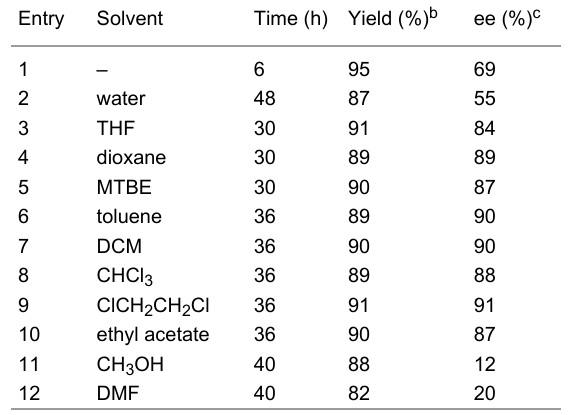
Table 2: Effect of the amount of solvent (DCE) on the enantio- selectivity of the Michael addition of acetone ( 2a ) to isatylidenemalono- nitrile ( 3a ) catalyzed by 1a TCA. a